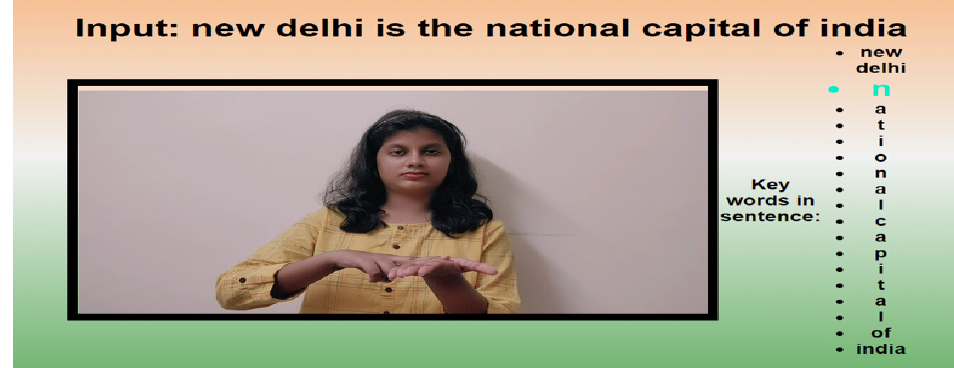
Figure 8. Case 1. Available ISL video for ‘national’ or ‘capital’ or ‘India’.